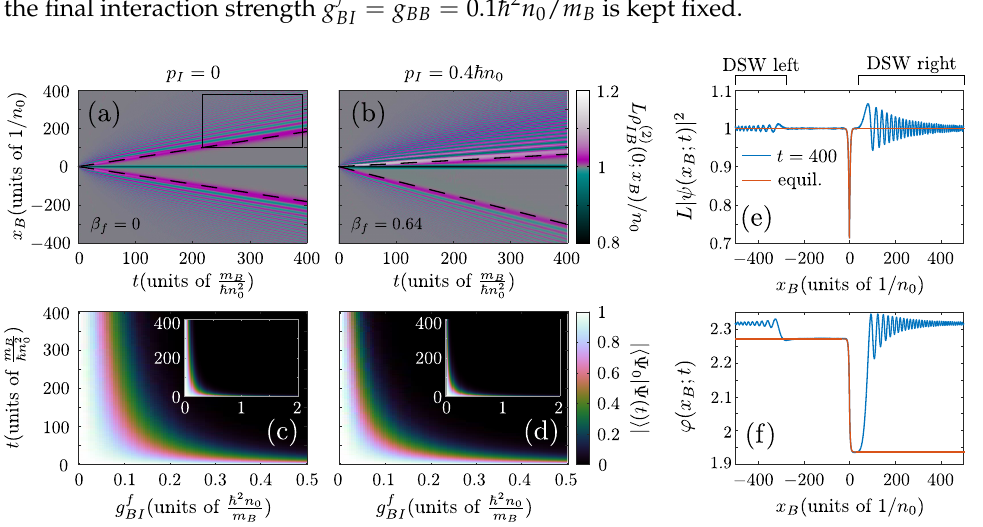
( 2 ) ( 0; x ) , for different initial impurity momenta, B IB = 0.1¯ h 2 n = g BB . The dashed lines 0 / m B BI = 0.1¯ h 2 n = 0.4¯ hn = 400 m B . For 0 / m B , p I 0 and t BI ¯ hn 2 0